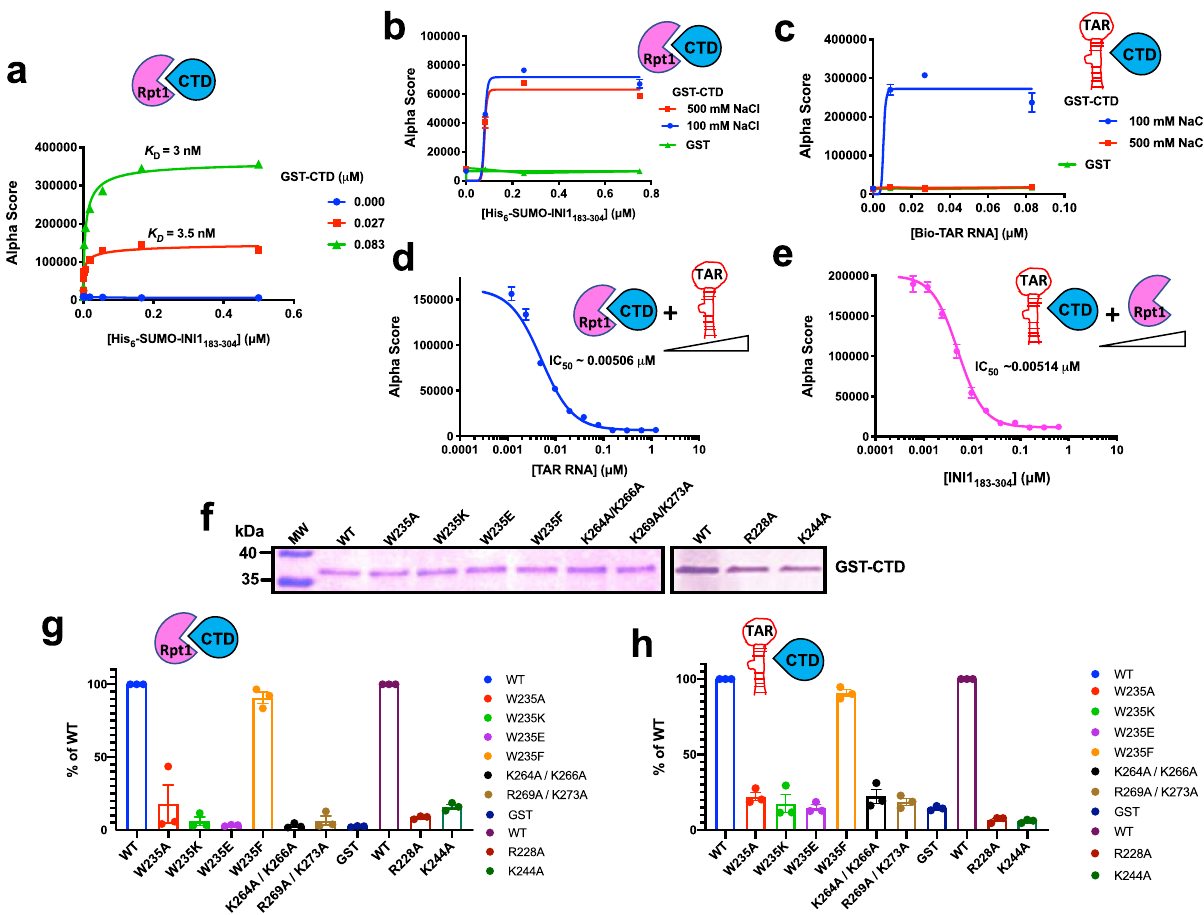
Fig. 4 Quantitative Alpha protein-protein interaction assay to determine the interaction of IN, CTD, and the mutants with INI1 and INI1 183-304 . a Interaction of GST-CTD with His 6 -SUMO-INI1 183-304 . A titration curve was generated with increasing concentrations of His 6 -SUMO-INI1 183-304 with two different fi xed concentration of GST-CTD and the interactions were detected as Alpha Score. The K D values were determined by nonlinear regression analysis using speci fi c binding with Hill slope analysis in GraphPad Prism. Data from one representative experiment is depicted. b , c Effect of salt on the interactions of GST-CTD either with His 6 -SUMO-INI1 183-304 or biotinylated(Bio)-TAR RNA ( n = 3 independent experiments). The interaction was tested using fi xed concentrations of GST-CTD (0.75 μ M) and increasing concentrations of His 6 -SUMO-INI1 183-304 (or Bio-TAR RNA) in two different NaCl conditions (100 and 500 mM); d , e Inhibition of GST-CTD interaction with His 6 -SUMO-INI1 183-304 or Bio-TAR RNA ( n = 6 independent experiments). Interactions were set up between GST-CTD (0.186 μ M) with His 6 -SUMO-INI1 183-304 (0.094 μ M), or GST-CTD (0.03 μ M) with Bio-TAR RNA (0.1 μ M) and increasing concentration of the third component (indicated in the X-axis) was added to the reaction. The IC 50 values were determined by fi tting the data to a four-parameter dose-response curve using GraphPad prism. f – h Interaction of GST-CTD and its substitution mutants with INI1 183-304 and TAR RNA ( n = 3 independent experiments). Representative Coomassie gel (from one out of three independent experiments) showing equal loading of the wild type and mutant proteins for the binding assays ( f ) and uncropped gels are provided in the source data. Interaction of GST-CTD and mutants with INI1 183-304 ( g ), and with biotinylated-TAR RNA ( h ). The graphs represent the % of the interaction of mutants as compared to that of wild type (WT) IN set at 100%. For both panels ( g ) and ( h ), WT and mutants are represented in different colors as indicated in the key provided next to the bar graphs. In all panels, except in a , graphs represent Mean ± SEM . In all panels the pink cartoon Rpt1 represents INI1 183-304 , blue cartoon CTD, IN-CTD, and red stem-loop, TAR